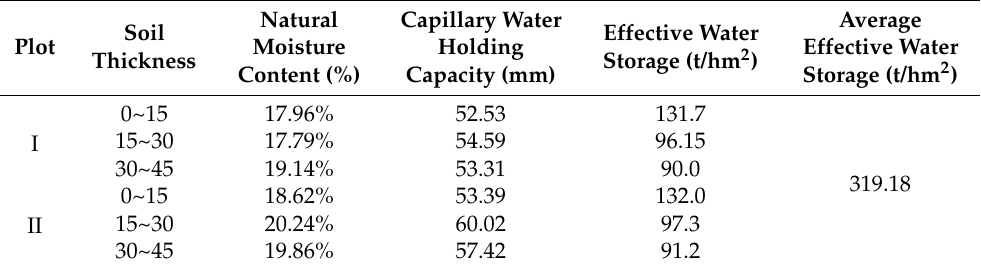
Average Effective Water Storage (t/hm 2 )